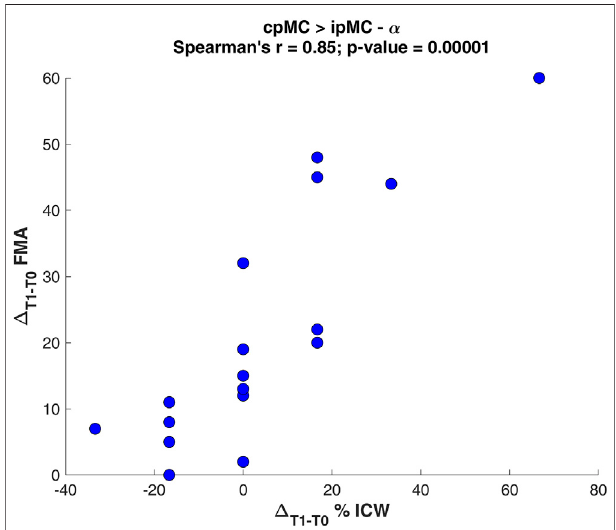
FIGURE 6 | Scatter plot of the Spearman ’ s correlation analysis between the variation Δ T1-T0 of percentage ICW for the connection cpMC → ipMC in α and the Fugl-Meyer Assessment variation Δ FMA T1-T0